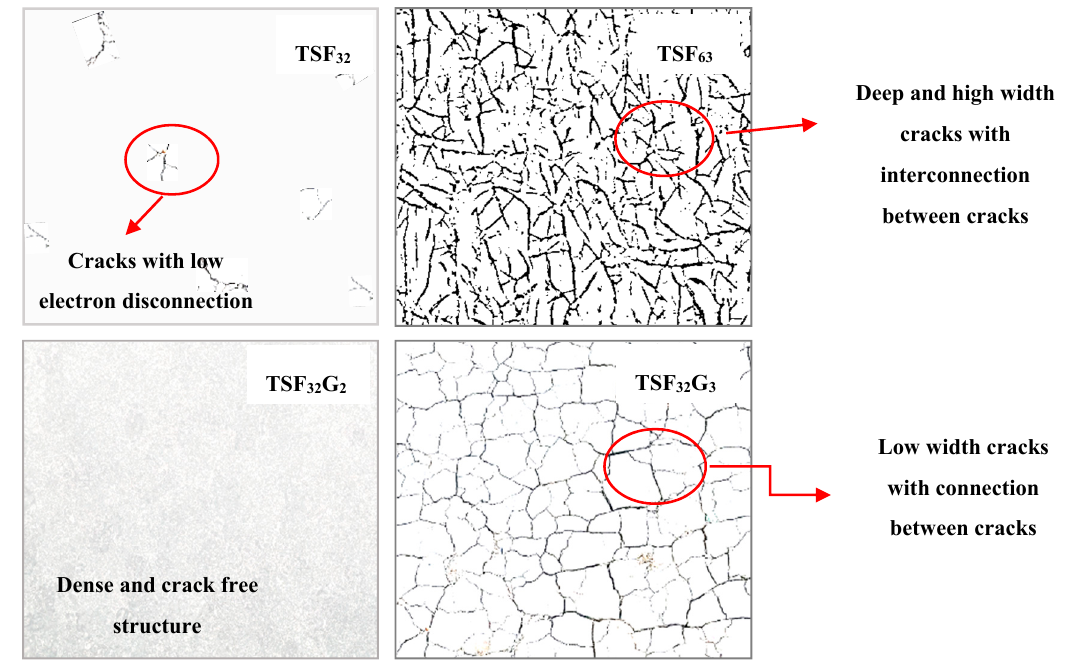
Figure 12. Schematic presentation of type and density of cracks in the TSF 32 : island structure, TSF 63 : branch structure, TSF 32 G 2 : dense structure, and TSF 32 G 3 : honeycomb structure coated films.